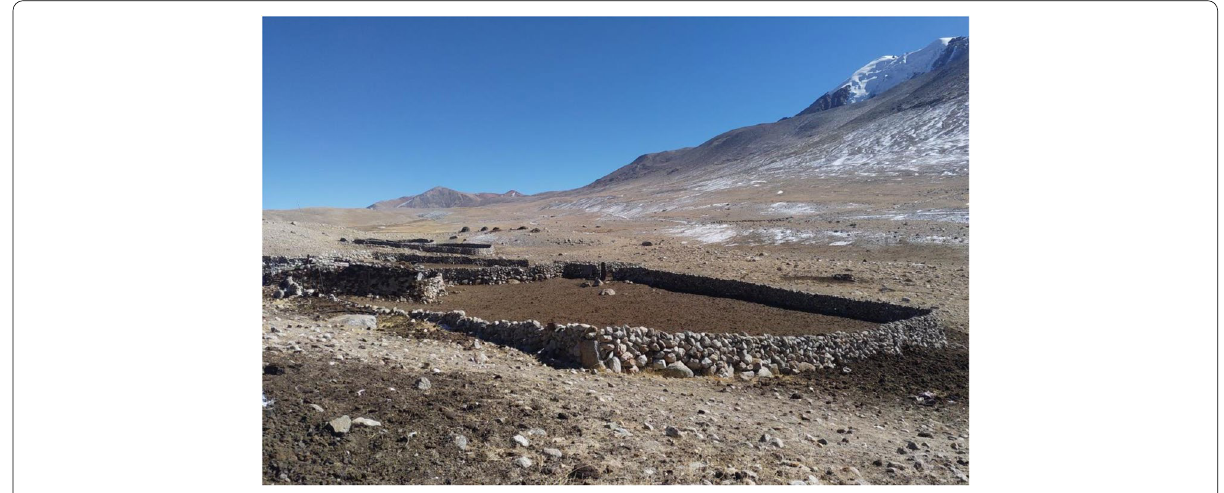
Fig. 8 Livestock pens located near a Dokpa